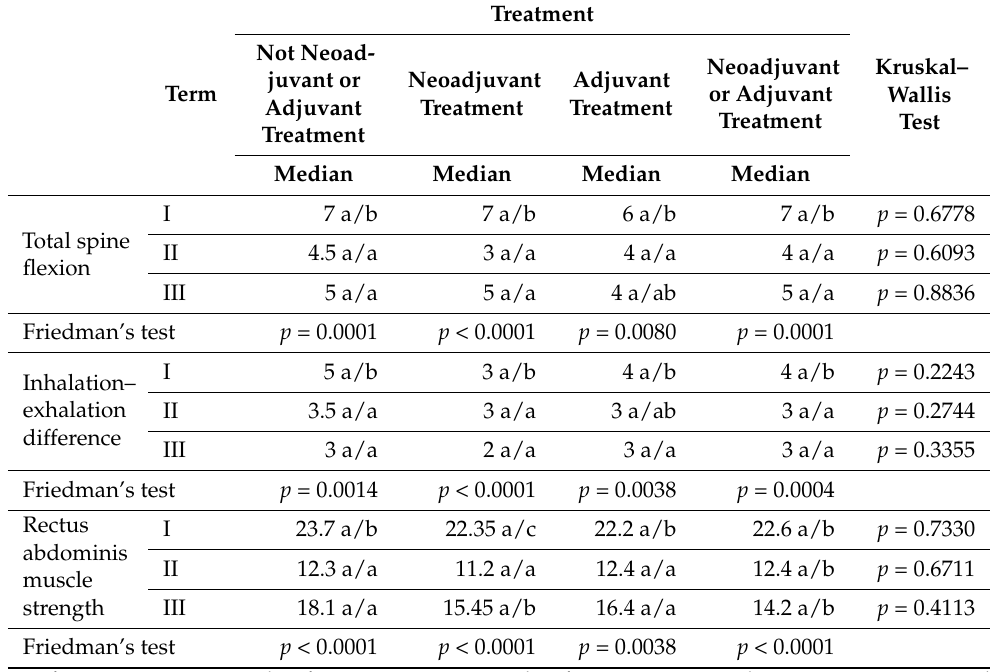
Table 4. Evaluation of total spine flexion, rectus abdominis muscle strength assessment and chest mobility assessment in the study groups in terms of neoadjuvant and adjuvant treatment. Treatment Term